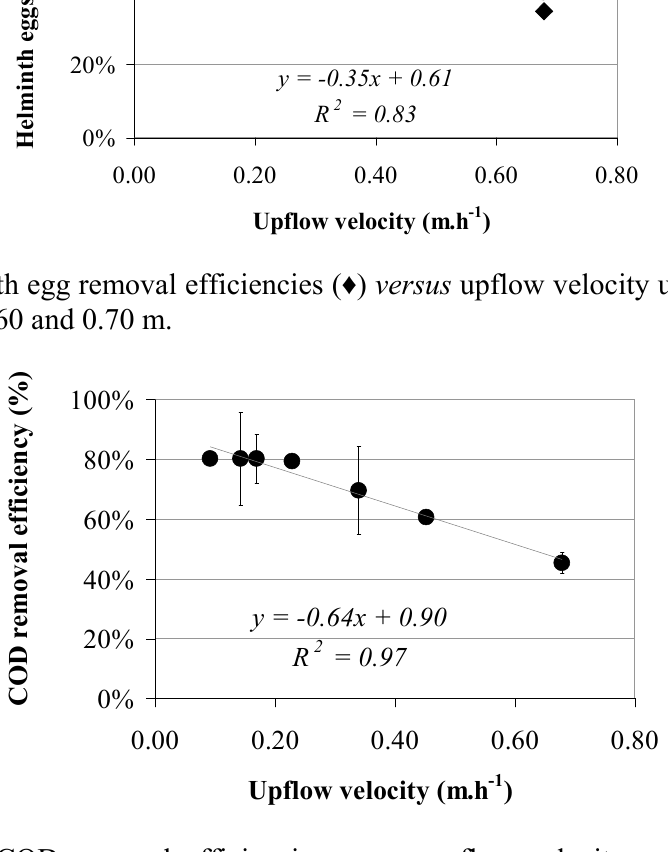
Figure 7. Total COD removal efficiencies versus upflow velocity using a sludge bed height between 0.60 and 0.70 m. Results show the average of two reactors and standard deviation and three measurements per